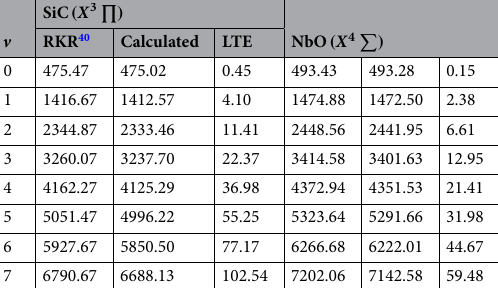
Table 2. Contains the calculated energy of vibrational levels (cm −1 ) and experimental data (cm −1 ) of SiC and NbO molecules for the modified shifted Morse potential